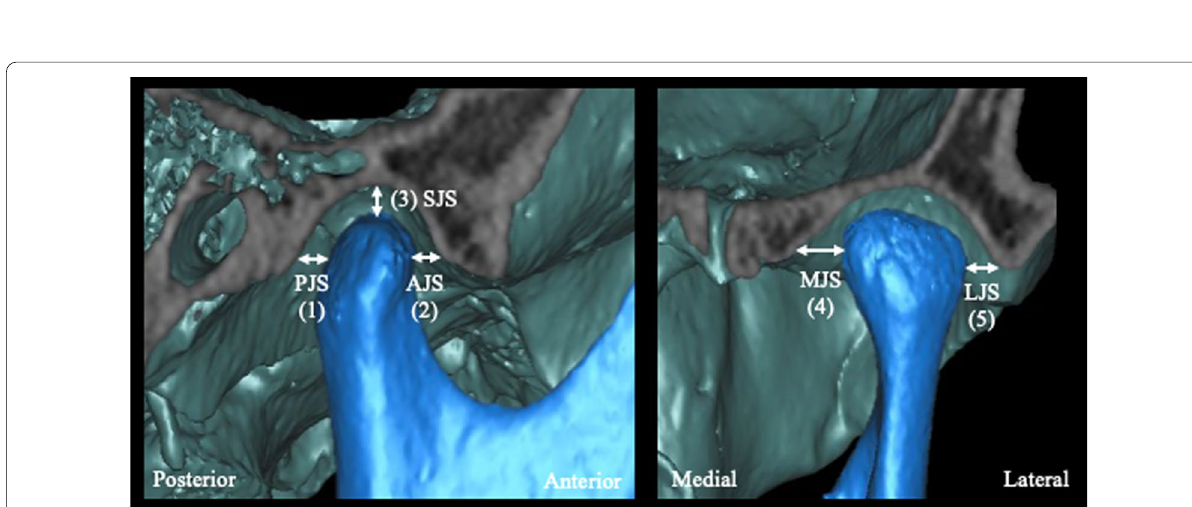
Fig. 4 Posterior joint space (PJS) (1) and anterior joint space (AJS) (2) were defined as the distance parallel to the FH plane between the posterior and anterior points of the condyle and the glenoid fossa outline, respectively. The superior joint space (SJS) (3), medial joint space (MJS) (4) and lateral joint space (LJS) (5) were defined as the distance between the most medial point, superior point, and lateral point of the condyle and the glenoid fossa,